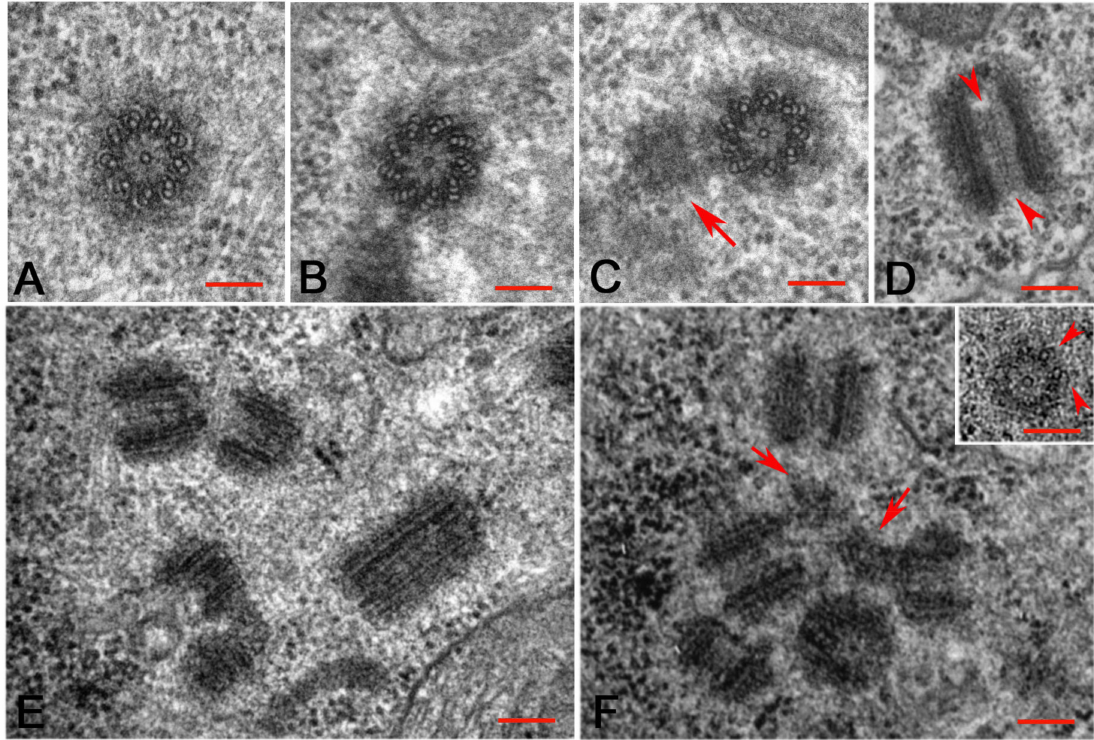
Figure 5. Structural details of the centrioles within the Drosophila ovariole. ( A ) Centriole from a cap cell showing the wall consisting of microtubule doublets. Details of germ cell centrioles consisting of a complete set of microtubule triplets ( B ) or mixed doublets and triplets ( C ); the centrioles with incomplete walls can support the assembly of procentrioles (arrow). ( D ) Longitudinal section of an elongated centriole showing the extension of the cartwheel (arrowheads). Details of centriole clusters in the oocyte cytoplasm during stages 4 ( E ) and 5 ( F ): note the variable length of the centrioles and the presence of centriole fragments (arrows). Short centrioles whose walls consists of single A-tubules and incomplete B-tubules (inset F , arrowheads) are also observed. Bars: A – D , inset F , 100 nm; E , F , 150